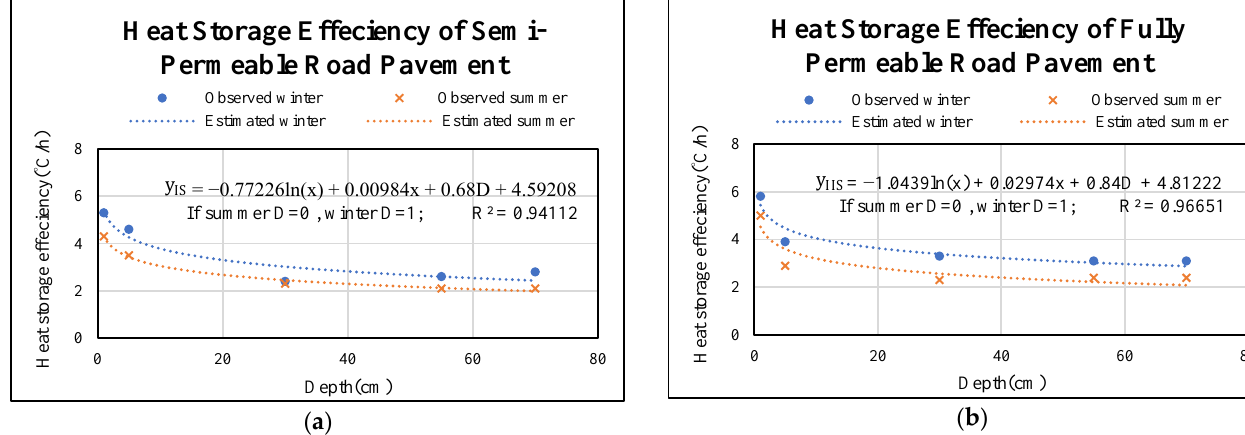
Figure 8. Relationships between heat storage efficiency verse permeable road pavements depth ( a ) Model for semi-permeable road pavement. ( b ) Model for fully permeable road pavement.